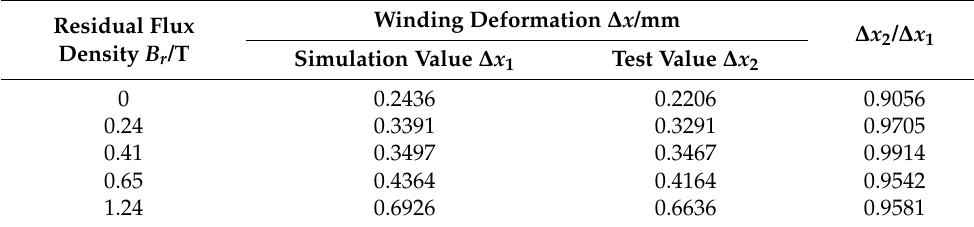
Table 3. The winding deformation ∆ x under different residual fluxes B r of line 5